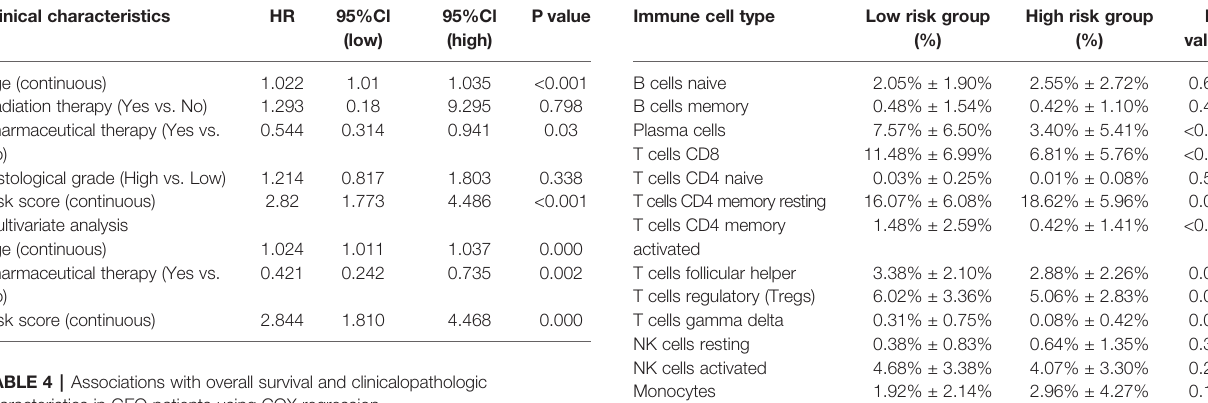
TABLE 3 | Associations with overall survival and clinicalopathologic characteristics in TCGA patients using COX regression. Clinical characteristics